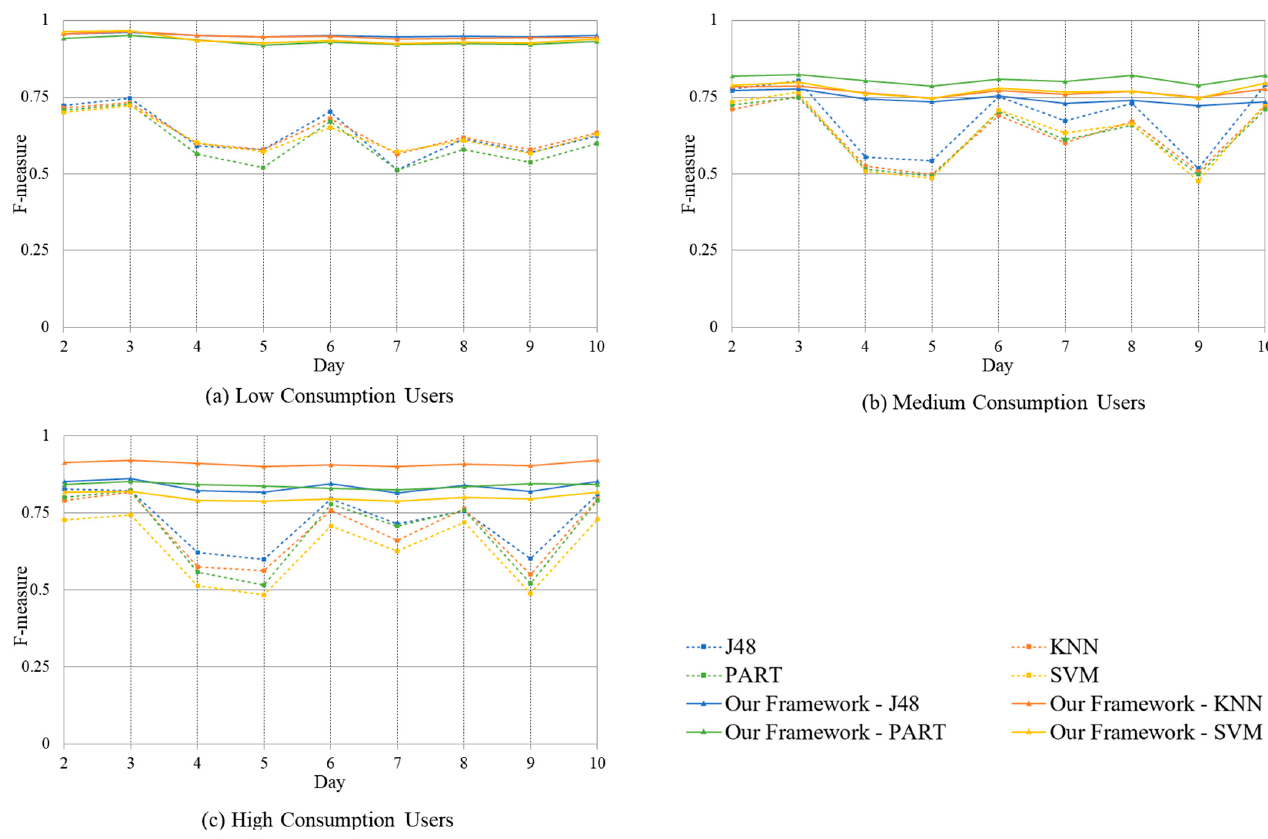
Figure 4. Change of F-measure on each day for each user group: ( a ) low consumption users; ( b ) medium consumption users; ( c ) high consumption users.